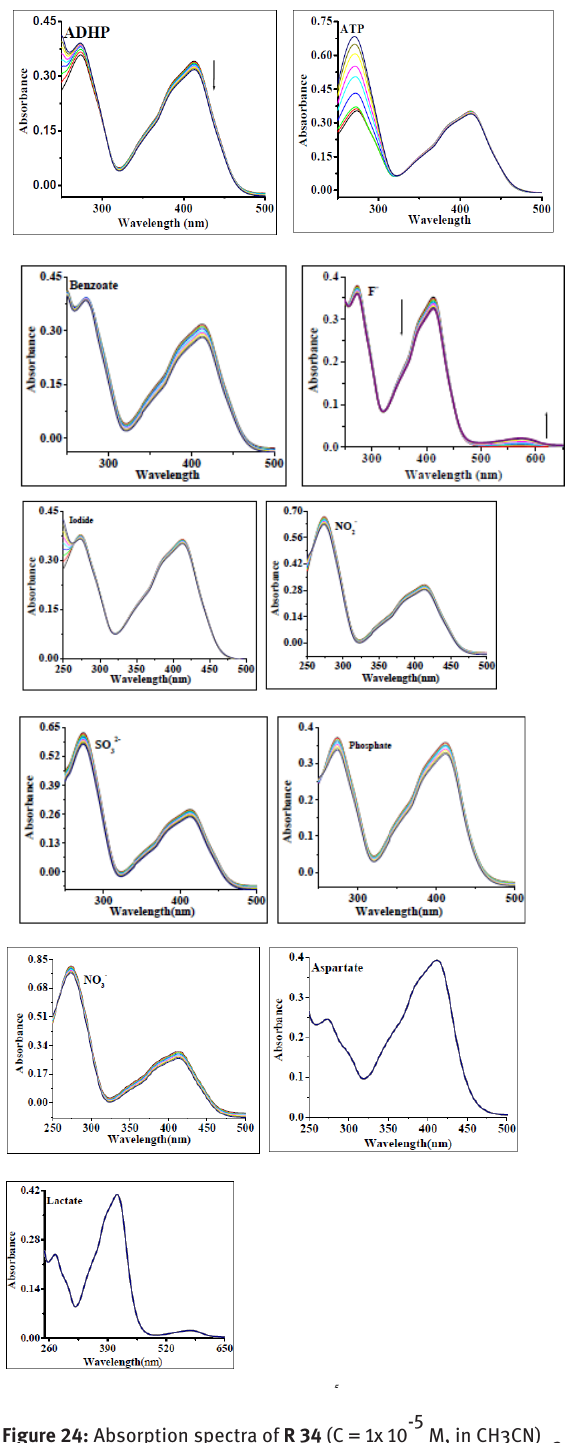
10-5 M, in CH3CN) BzO- F- I- NO2- NO3- PO43- , , , , , ,